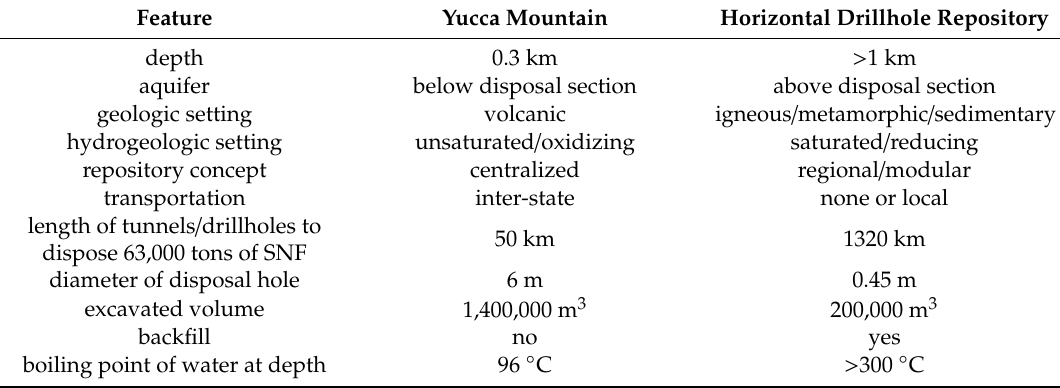
Table 3. Comparison between Yucca Mountain repository and the proposed deep horizontal drillhole